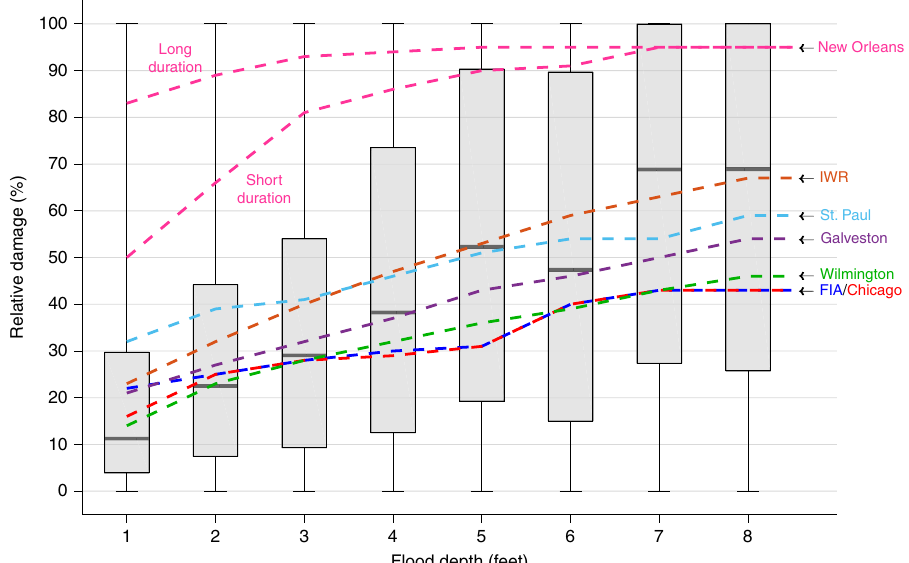
Fig. 1 Comparison of NFIP-derived and US federal depth – damage relationships. The boxplots show the distribution of NFIP-derived relative structure damages (structural damages as a percentage of building value) at each fl ood depth increment for residential buildings with one story and no basement. Minima and maxima are shown at the foot of the whiskers, 25th and 75th percentiles bound the shaded box with medians (50th percentile) within. Dashed lines represent select US depth – damage curves for this type of building; labels represent the USACE District or other source of these functions. These curves relate to freshwater fl ooding; the New Orleans District has a separate curve for both long and short duration fl